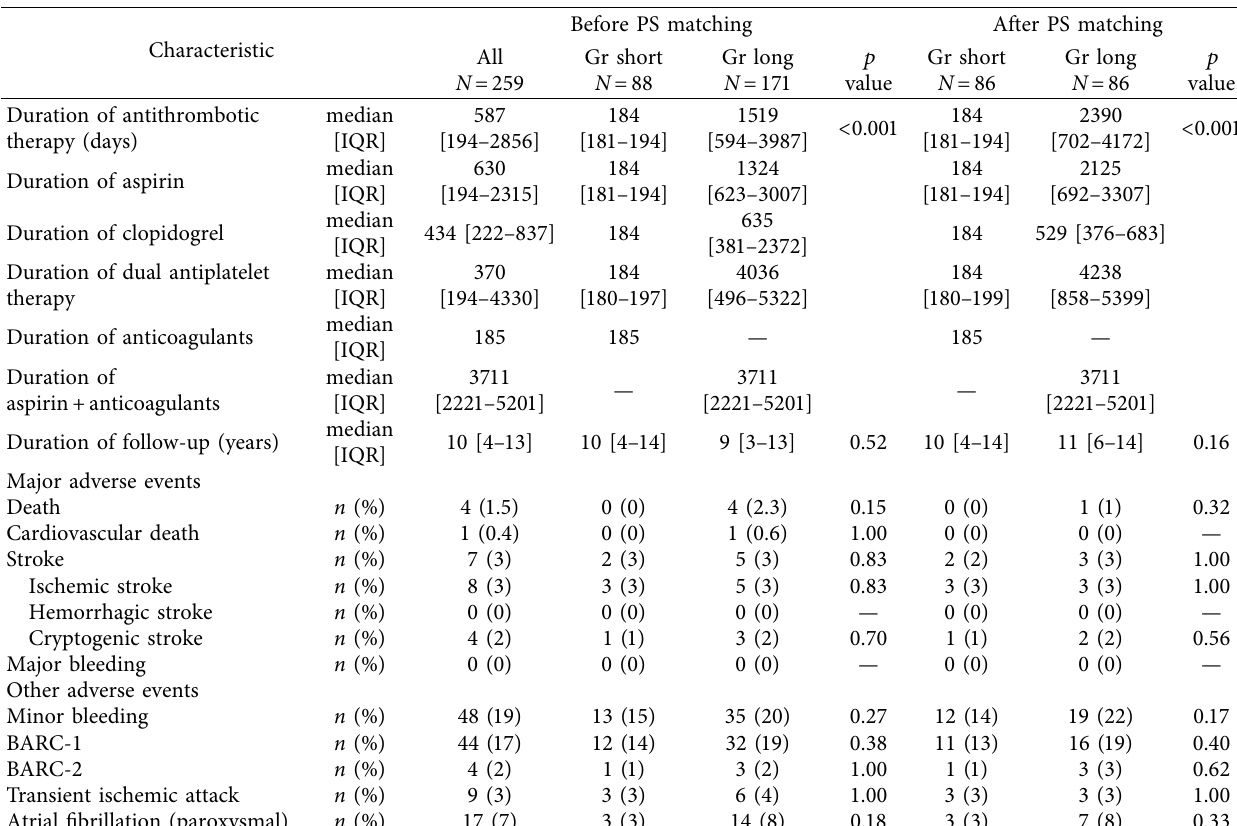
Table 3: Follow-up after PFO closure.